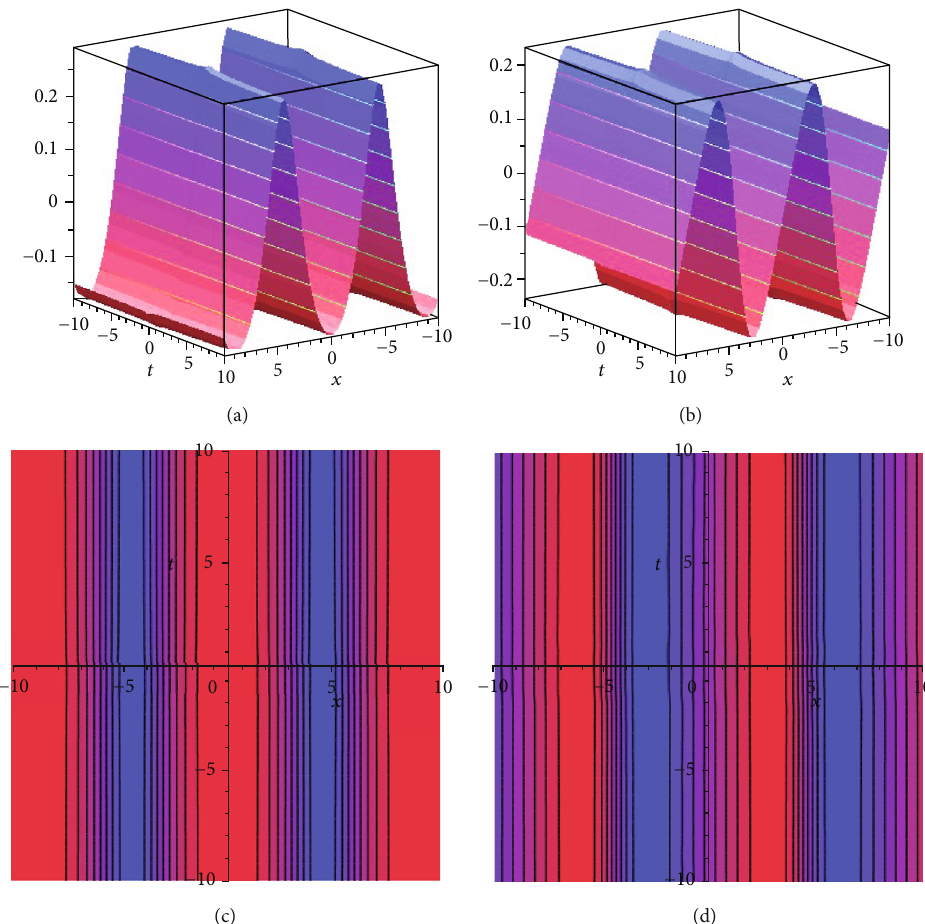
ð x , t Þ : (a) real three-dimensional shape, (b) complex three-dimensional shape, (c) 5